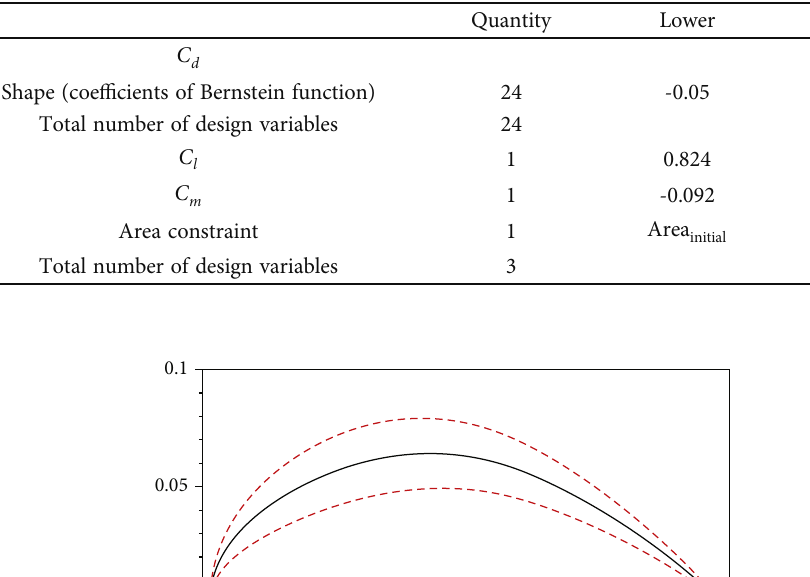
Table 5: RAE 2822 airfoil optimization problem description.